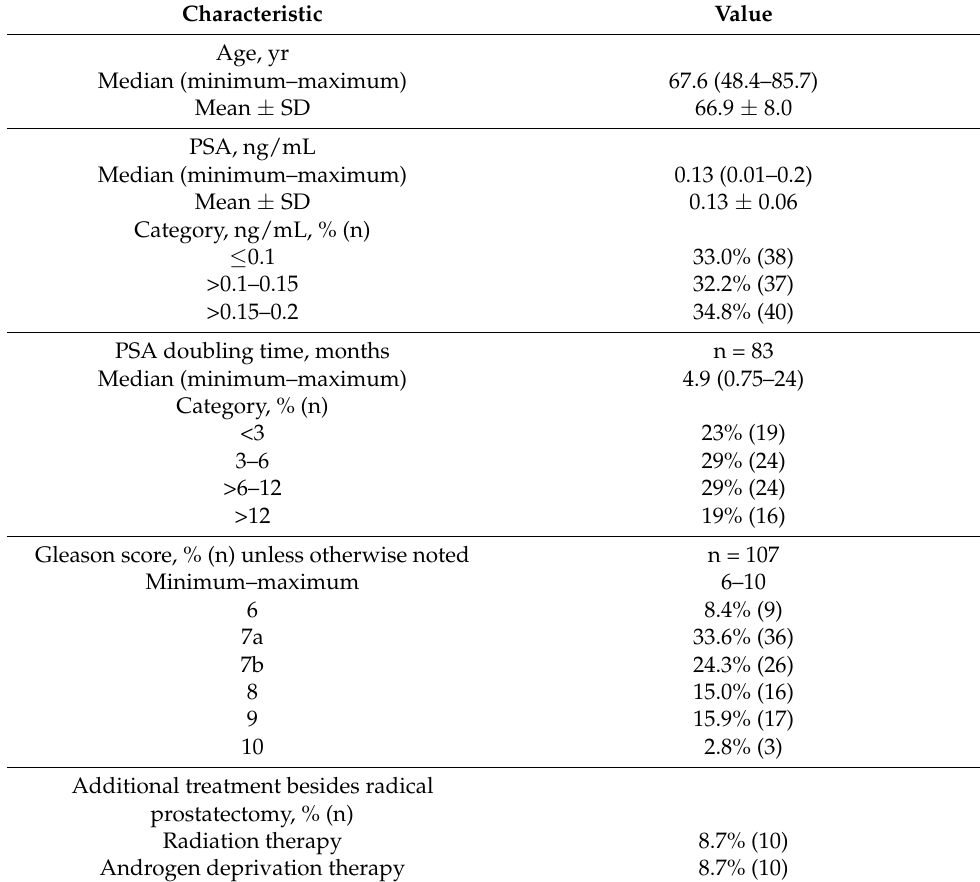
Table 1. Patient characteristics of 115 men with BCR and very low PSA